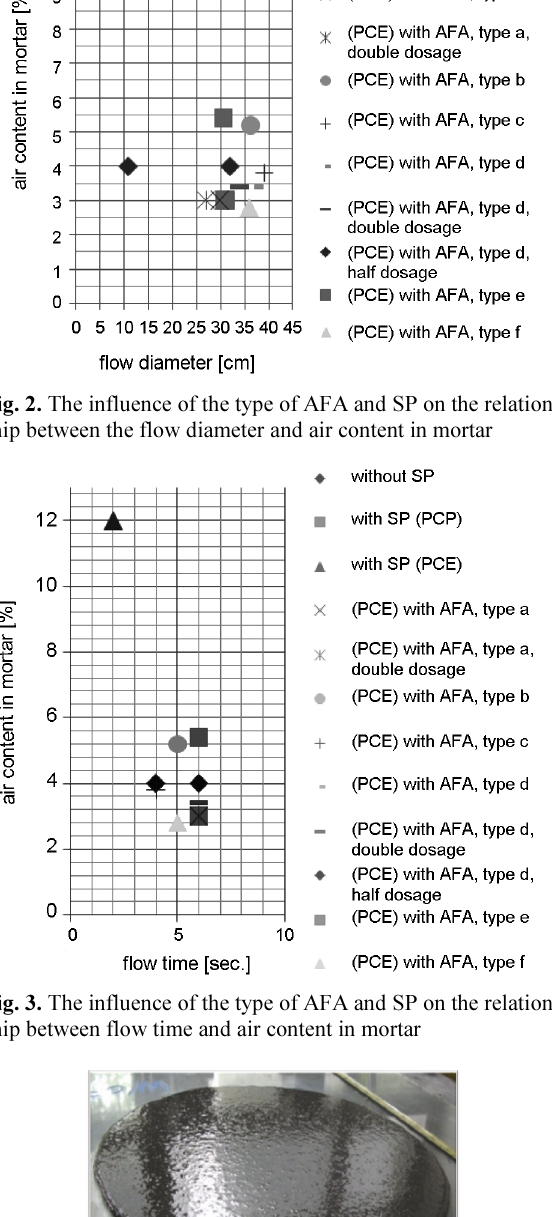
Fig. 5. The influence of the type of AFA on the flow diameter of mortar mixes (after 20 and 60 minutes)